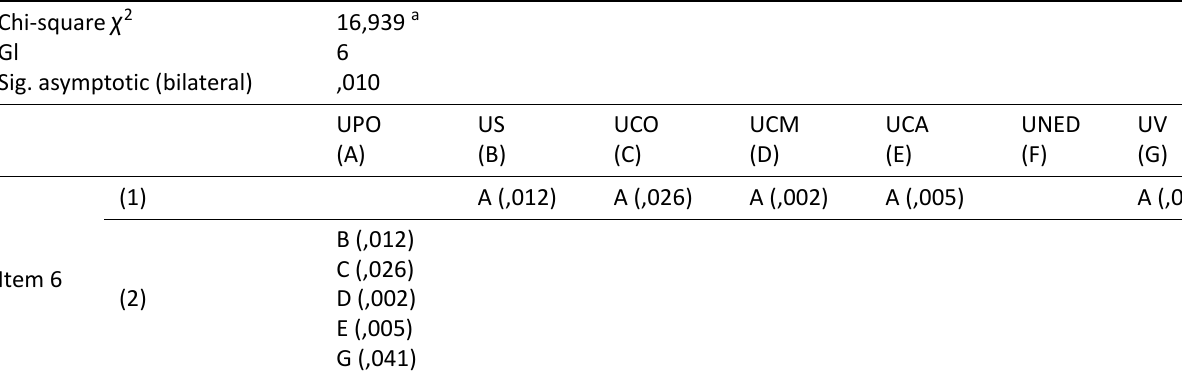
Table 3. Chi‐square and comparisons of proportions (item 6).